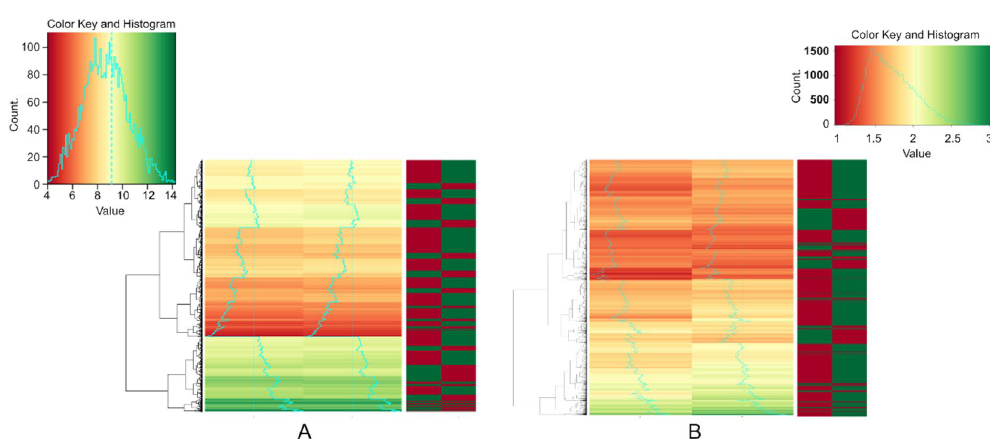
Figure 2. Genetic signature of pregnancy through gene-by-gene analysis. Heatmaps. (A) Heatmap of all 2123 probes found differentially expressed (adjusted p value < 0.05) between nulliparous (left column) and parous (right column). Two heatmaps are presented to show specific features of the FFTP genomic signature associated with up/down regulation. Each horizontal line corresponds to the same probe in both heatmaps. The left heatmap clusterizes according to similarity of expression levels (red to green: low to high expression level). The right heatmap shows downregulation (red) and upregulation (green). As the histograms (blue curves) depict, upregulation for parous is more frequent in the central orange/yellow region (low/intermediate expression values in nulliparous). For high expression values (bottom region), downregulation for parous is slightly more frequent than overregulation. There is a general tendency to upregulation in parous, also found by 27 , with an up/down regulation ratio of 2.17. (B) Heatmap of changes in entropy for the 18,022 probes showing significant changes ( p value < 0.05). Cluster analysis shows a generalized gain in entropy induced by FFTP, which is not related to the entropy level in nulliparous (histograms/blue curves): The redefinition of the channels and stimuli reaching genes and their performance of additional and more complex functions as a consequence of FFTP homogenously affects all